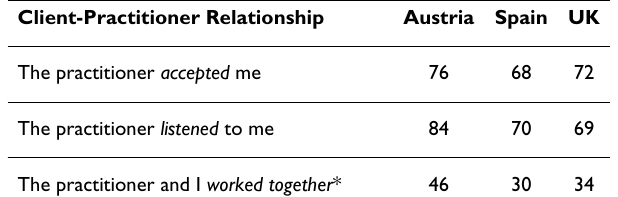
Table 3: The Client-Practitioner Relationship (% 'strongly agree'/ % 'very much so') Client-Practitioner